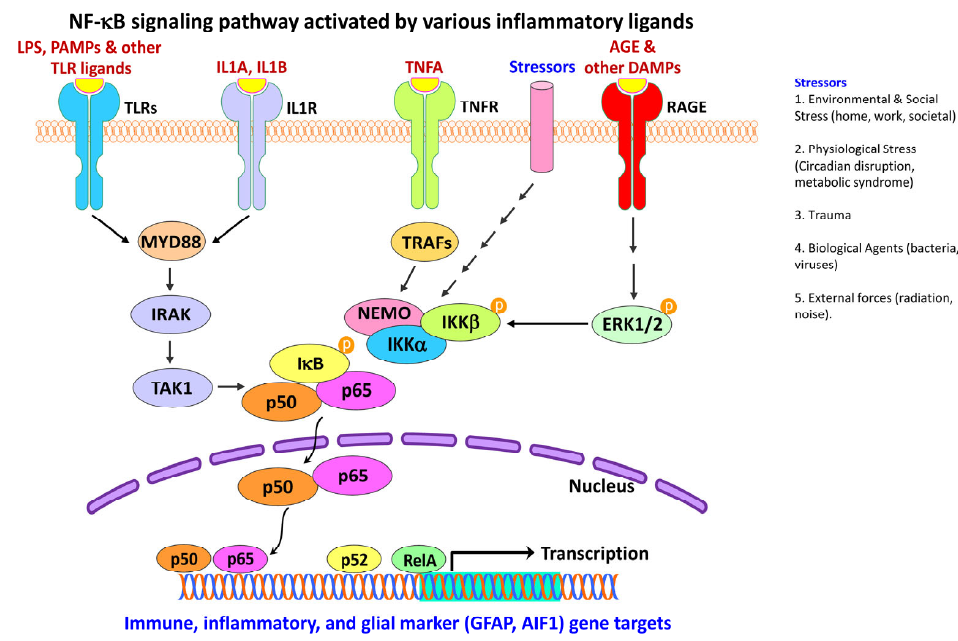
Figure 6. NF- κ B signaling in neuroinflammatory response. Schematic representation depicts activa- tion and regulation of NF- κ B signaling pathways by various inflammatory ligands. NF- κ B activation is initiated when ligands stimulate various cell-surface receptors, e.g., TLR2, IL1R, TNFR or RAGE. Upon stimulation, TLRs and IL1R assembles the cytoplasmic MYD88 complex, which recruits IRAK and TAK1. Stimulation of TNFR recruits TRAFs. TAK1 and TRAFs activate the downstream kinase IKK, which in turn phosphorylate the NF- κ B inhibitor I κ B α , leading to ubiquitin-dependent I κ B α degradation and NF- κ B activation. Once activated, TRAFs function as an E3 ubiquitin ligase that catalyzes the synthesis of K63-linked polyubiquitin chains conjugated to itself, NEMO. A complex signal transduction process then starts as soon as TNFRs are activated. IKK is ultimately triggered and leads to the phosphorylation of I κ B, which results in I κ B ubiquitination and degradation. When I κ B is degraded, the remaining NF- κ B dimer (e.g., p65/p50 or p50/p50 subunit or their putative combination) translocates to the nucleus, which further binds to a DNA consensus sequence of target immune, inflammatory or glial marker (e.g., GFAP, AIF1) genes. Similarly, the binding of AGE and other DAMP ligands to RAGE receptor, causes ERK1/2 phosphorylation that further leads to activation and phosphorylation of the NEMO-IKK complex, NF- κ B activation, and subsequent translocation of the NF- κ B dimer (e.g., p65/p50 or p50/p50 subunit or their putative combination) to the nucleus to regulate transcription of immune and inflammatory genes including glial markers, e.g., GFAP, AIF1. Over ‐ expression of RAGE produces vicious cycles that perpetuate oxidative stress and contribute to neuroinflammation by nuclear factor ‐ kB (NF ‐ kB) up ‐ regulation. Black arrows indicate the activation process and multiple arrows indicate several unknown inter ‐ mediates in the signaling cascade. AGE, advanced glycation end ‐ products; AIF1, allograft inflam ‐ matory factor 1 (also known as IBA1, ionized calcium ‐ binding adapter molecule 1); DAMP, damage ‐ associated molecular patterns; ERK1/2, extracellular signal ‐ regulated kinase 1 and 2; GFAP, glial fibrillary acidic protein; IKK α , inhibitor of nuclear factor kappa ‐ B kinase subunit alpha (IKKA; also known as CHUK, component of inhibitor of nuclear factor kappa B kinase complex); IKK β , inhibitor of nuclear factor kappa ‐ B kinase subunit beta (IKKB; also known as IKBKB); IL1A, interleukin 1 alpha; IL1B, interleukin 1 beta; IL1R, interleukin 1 receptor; IRAK, interleukin 1 receptor associated kinase 1; IRAK, interleukin 1 receptor ‐ associated kinase; I κ B, inhibitor of nuclear factor kappa B; LPS, lipopolysaccharide; MYD88, MYD88 innate immune signal transduction adaptor (also known as myeloid differentiation primary response gene 88; NEMO, NF ‐ kappaB essential modulator (also known as IKBKG, inhibitor of nuclear factor kappa ‐ B kinase regulatory subunit gamma); NF ‐κ B, nuclear factor kappa B; P, phosphate group; p50, protein p50 (the functional subunit of the 105 kD precursor protein coded by the gene NFKB1, nuclear factor kappa B subunit 1); p52, protein p52 (the functional subunit of the 100 kD precursor protein coded by the gene NFKB2, nuclear factor kappa B subunit 2); p65, protein p65 (also known as RELA, RELA proto ‐ oncogene, NF ‐ KB Subunit or V ‐ Rel avian reticuloendotheliosis viral oncogene homolog A); PAMPs, pathogen ‐ associated molecular